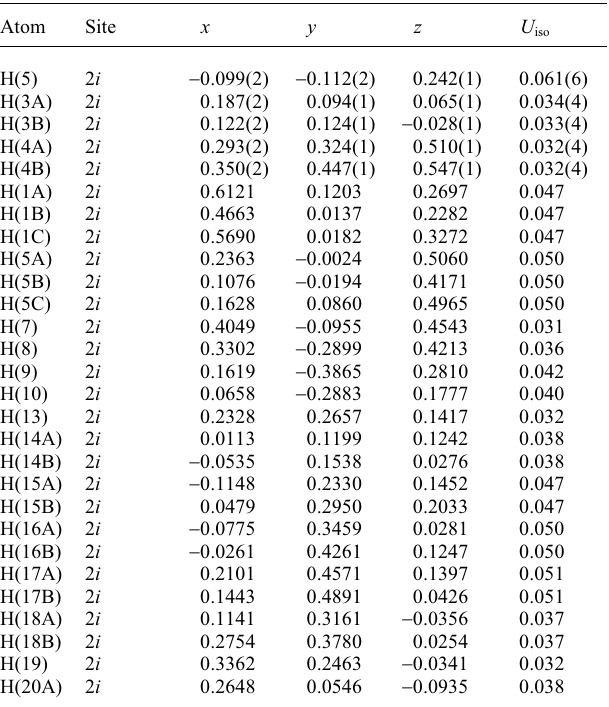
Table 2. Atomic coordinates and displacement parameters (in Å 2 )